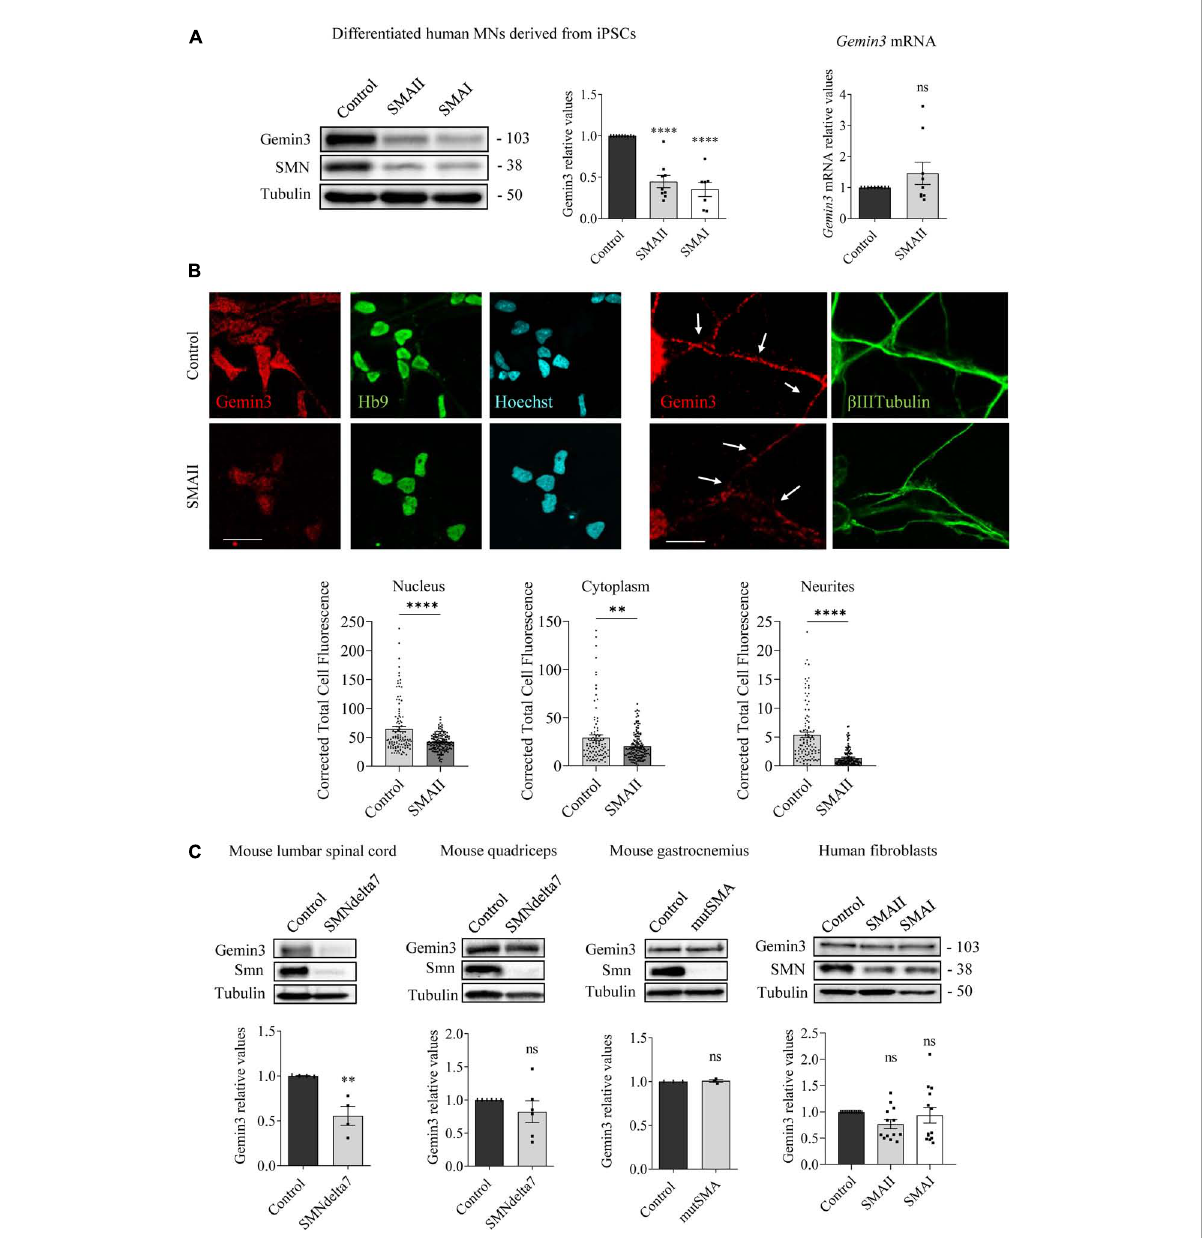
FIGURE3 Gemin3 protein reduction in spinal muscular atrophy (SMA) human motoneurons (MNs) and mouse spinal cord. (A) Control and SMAII and SMAI MNs were differentiated for 7 days; (left) total cell lysates were obtained and submitted to western blot using anti-Gemin3 and anti-SMN antibodies. Membranes were reprobed using anti- α -tubulin antibody. Graph values represent the expression of Gemin3 versus α -tubulin and correspond to the quantification of at least seven independent experiments ± SEM; (right) total RNA was extracted and reverse transcribed to cDNA. Gapdh gene was used as control. Graph values are the mean of Gemin3 gene expression from three independent experiments ± SEM. (B) Representative immunofluorescence images of 7 days cultures SMAII using anti-Gemin3 antibody (red), anti-HB9 antibody (green left), anti- β IIITubulin antibody (green right), and Hoechst staining (blue) to identify MN nucleus are shown. Graph values represent the mean of relative Gemin3 fluorescence measured in the cell nucleus, cytoplasm, and neurites, corresponding to the quantification of at least 100 cells per condition from three independent experiments ± SEM. Scale bar, 25 µ m (left) and 15 µ m (right). Arrows indicate MN neurites. (C) Total cell lysates of P5 control and SMNdelta7 spinal cords and quadriceps, P2 control and mutSMA gastrocnemius, and 48 h cultured control, SMAII, and SMAI patient fibroblasts, were submitted to western blot analysis using anti-Gemin3 and anti-SMN antibodies. Membranes were reprobed using anti- α -tubulin antibody. Graph values represent the expression of Gemin3 versus α -tubulin and correspond to the quantification of at least four independent experiments ± SEM. Asterisks indicate significant differences using Student t -test or one-way Anova with Dunnett’s multiple comparisons post-test ( ∗∗ p < 0.005; ∗∗∗∗ p < 0.0001 ns, no significant differences p >